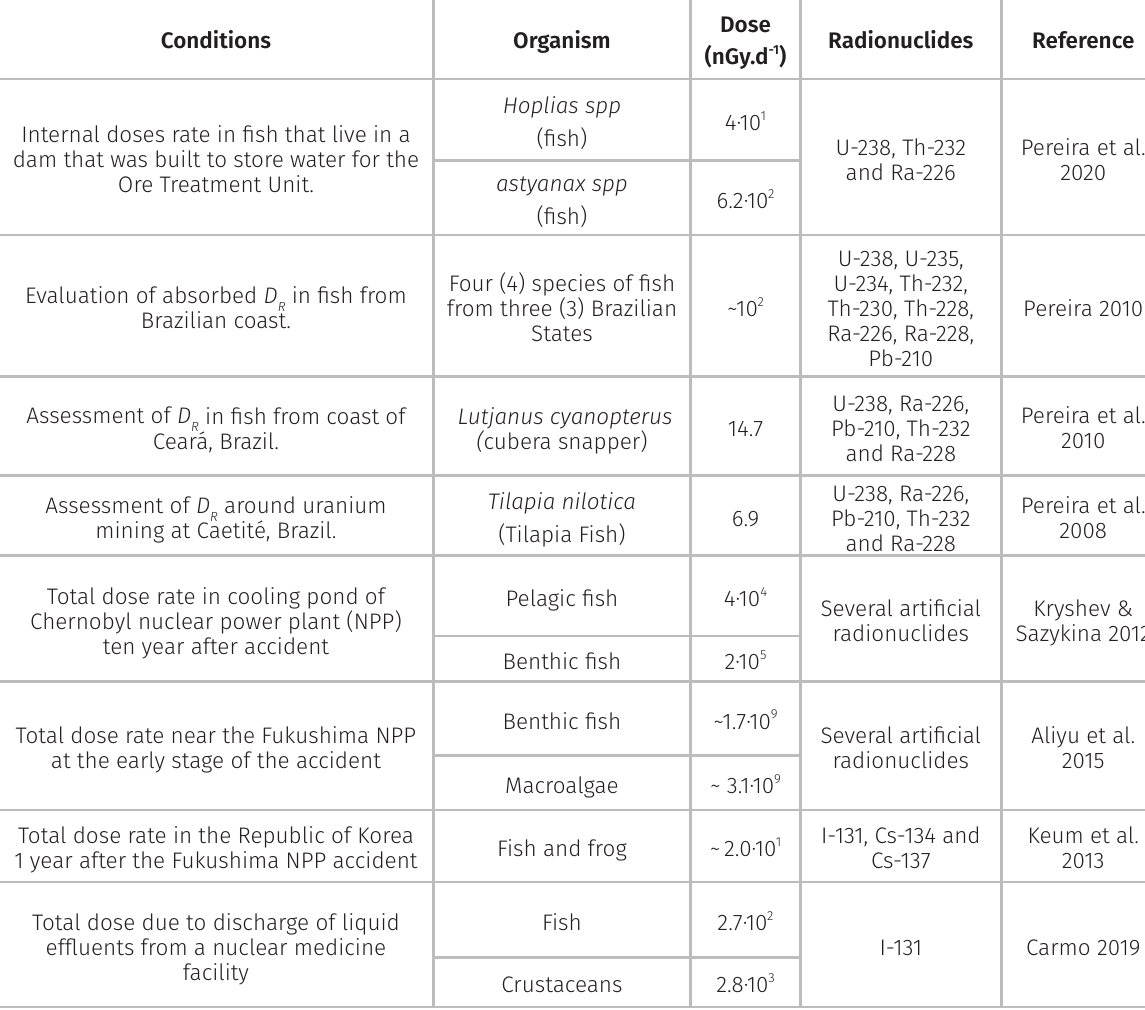
Dose Radionuclides Reference (nGy.d -1 )